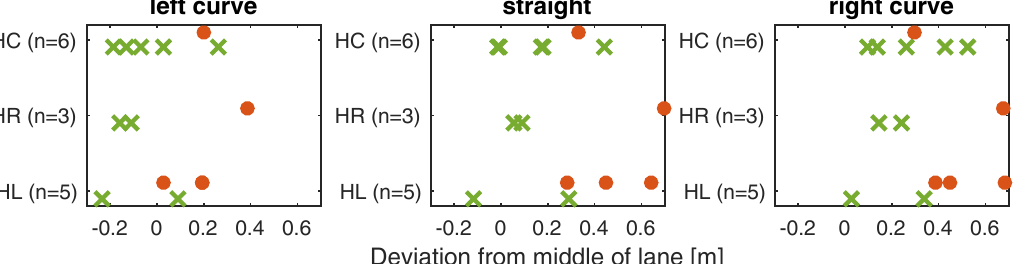
Figure 7 . Average lane position during left curves (left), on a straight road (middle) and during right curves (right). The means and standard deviations for subjects who passed and failed the driving task are depicted as crosses (green) and circles (red), respectively. HC: control group, HR: HVFD patients with a right-sided visual field defect, HL: HVFD patients with a left-sided defect.